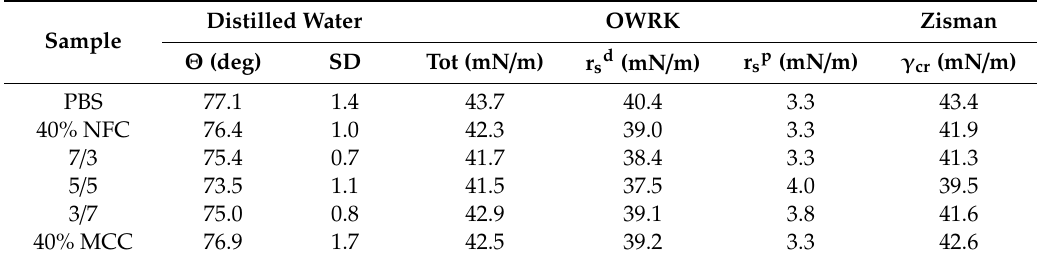
Table 4. Surface properties of PBS and PBS / cellulose